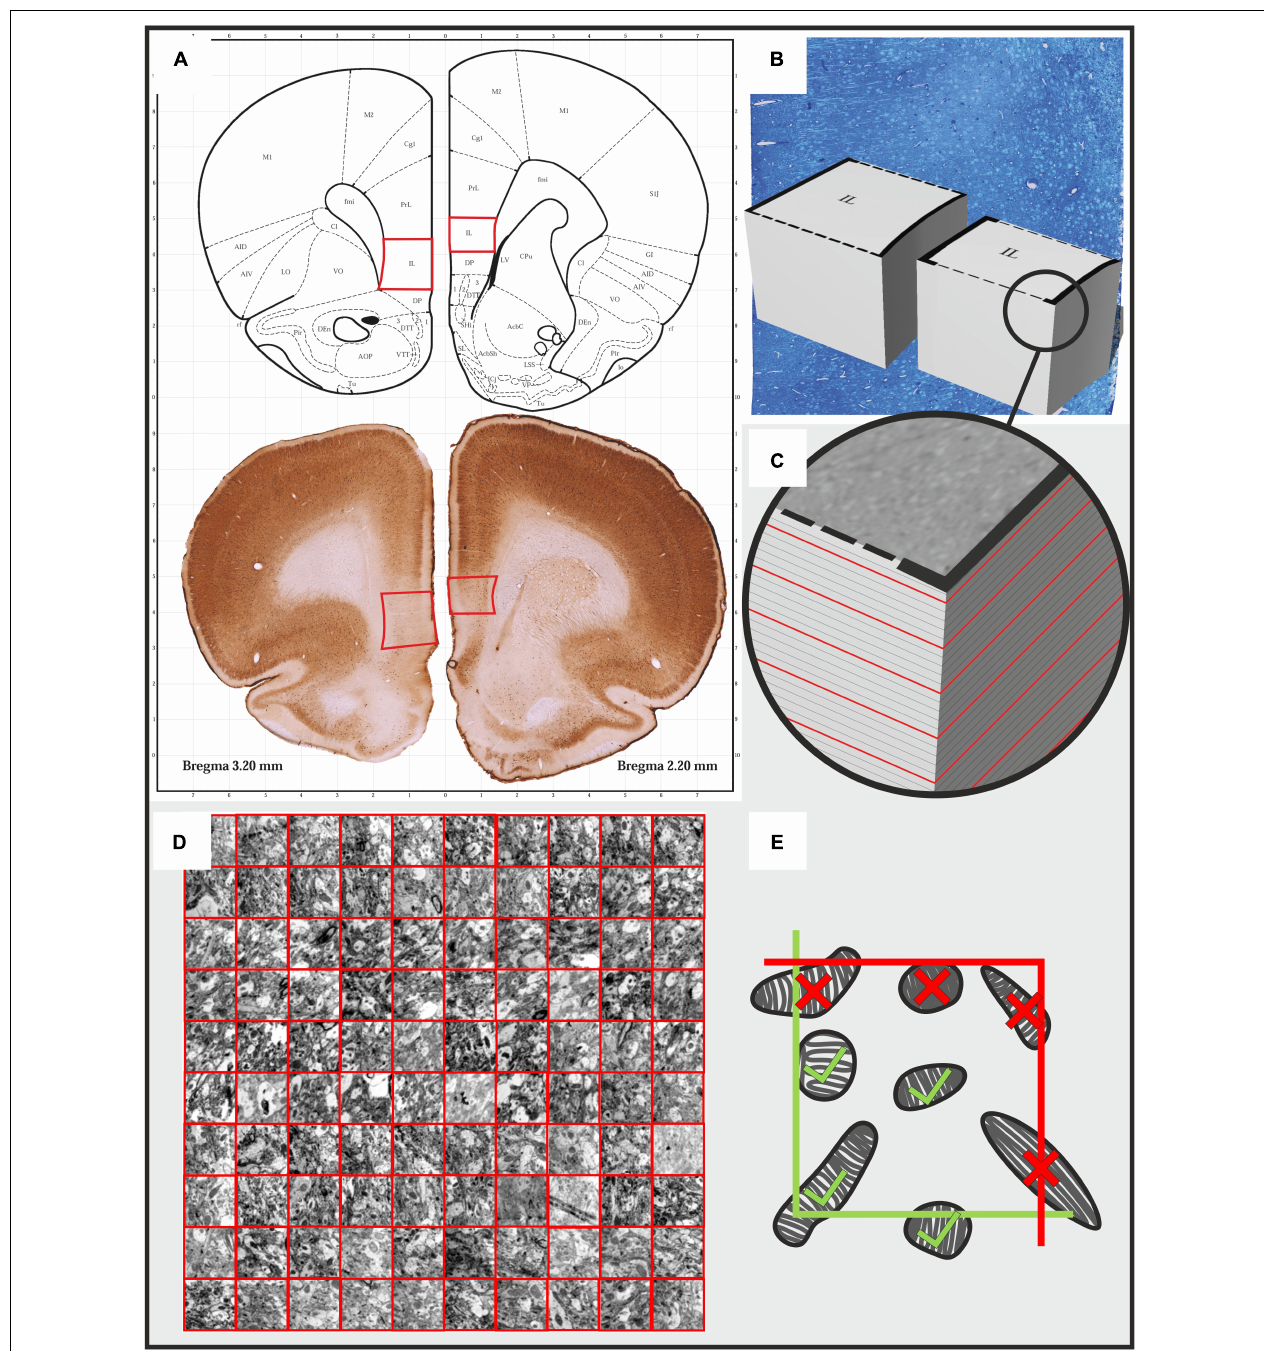
FIGURE 1 | Illustrating the protocol for the systematic quantitative analysis of mitochondrial morphology and number in the infralimbic cortex of rats. (A) Two pieces of 80 µ m thick coronal sections from the prefrontal cortex were selected between Bregma coordinates of 2.2 - 2.3 mm. Afterward, tissue fragments containing the infralimbic cortices were cut out and re-embedded in durcupan resin to produce tissue blocks for further ultra-sectioning. (B,C) First, semi-thin sections were cut and stained with toluidine blue dye to determine the exact area for further ultra-sectioning. (C) Afterward, serial 60 nm ultrathin sections were sectioned and we collected every 5th sections on single slot copper grids. The red lines on the image indicate the ultrathin sections. From each animal, we examined 10 ultrathin sections with the electron microscope. (D) In every ultrathin section, in each cortical layer, we made at least 10 non-overlapping photomicrographs using a sampling line with a random starting point. We analyzed 90 photomicrographs in each cortical layer of each animal. Mitochondria were counted and their cross-sectional profiles were outlined in these 40000 × magnified images. (E) For the quantification we used an unbiased counting frame (3.87 × 3.87 µ m). Mitochondria profiles touching the exclusion (red) lines were not